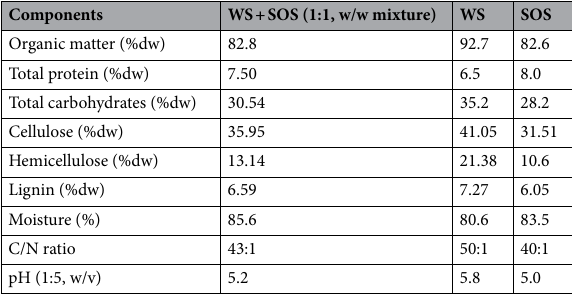
Table 1. Properties of the basic substrates (dw: dry